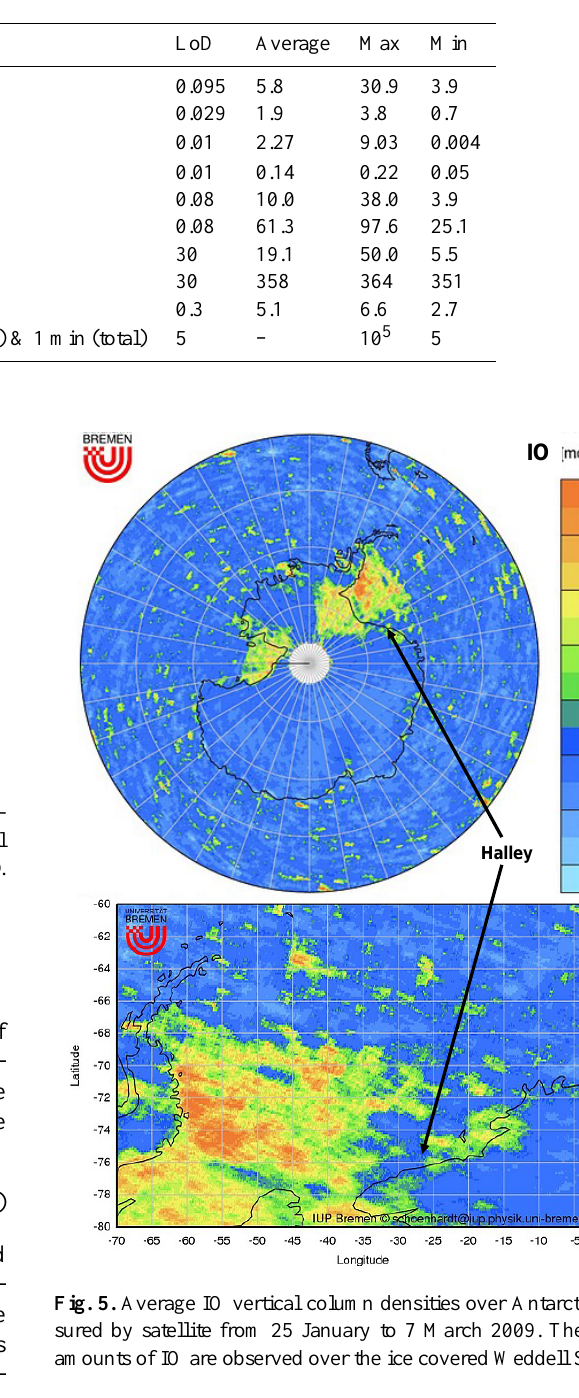
Fig. 6. Average ice coverage (left) and extent (right) for February 2009, together with the median ice edge (pink line). Courtesy NSIDC.